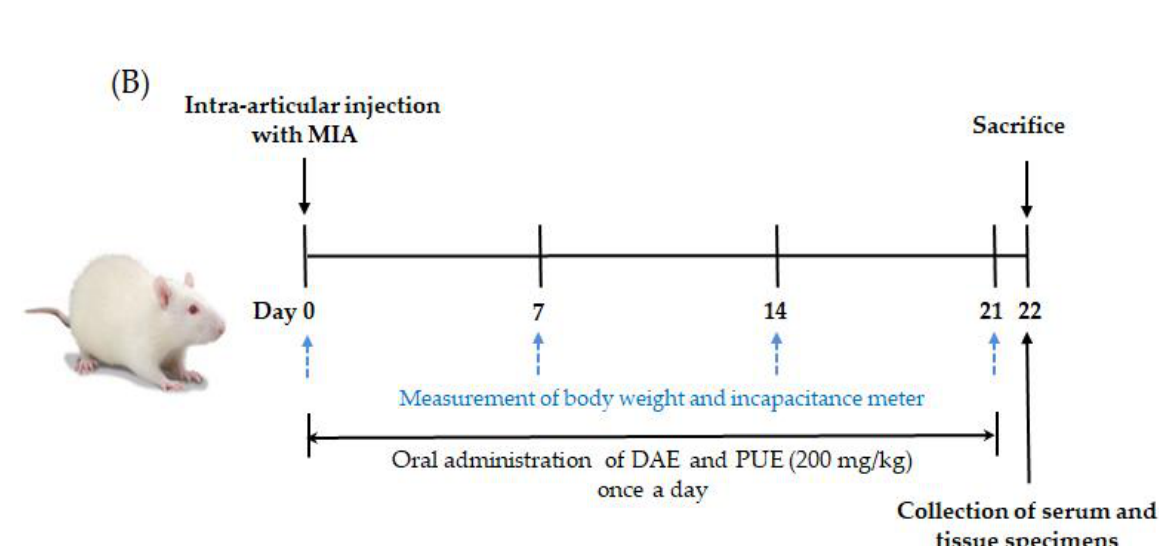
Figure 6. Experimental plant materials and protocol. ( A ) Representative photographs of dried roots of Dipsacus asperoides and Phlomis umbrosa used in this study. ( B ) The experimental protocol for inducing osteoarthritis (OA) and treatment with extracts. SD rats were divided randomly into five groups: NC, MIA, MIA + DAE, MIA + PUE, and MIA + IM ( n = 7 per group). MIA, monosodium iodoacetate; DAE, Dipsacus asperoides extract; PUE, Phlomis umbrosa extract; IM, indomethacin.